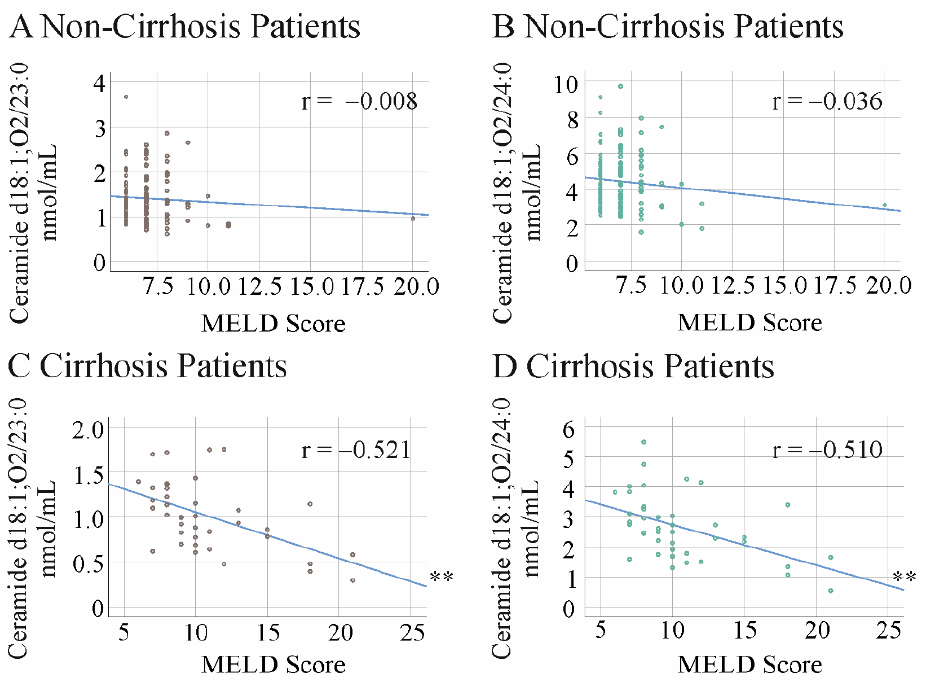
Figure 3. Correlation of ceramide d18:1;O2/23:0 and 24:0 with the MELD score at therapy end. ( A )